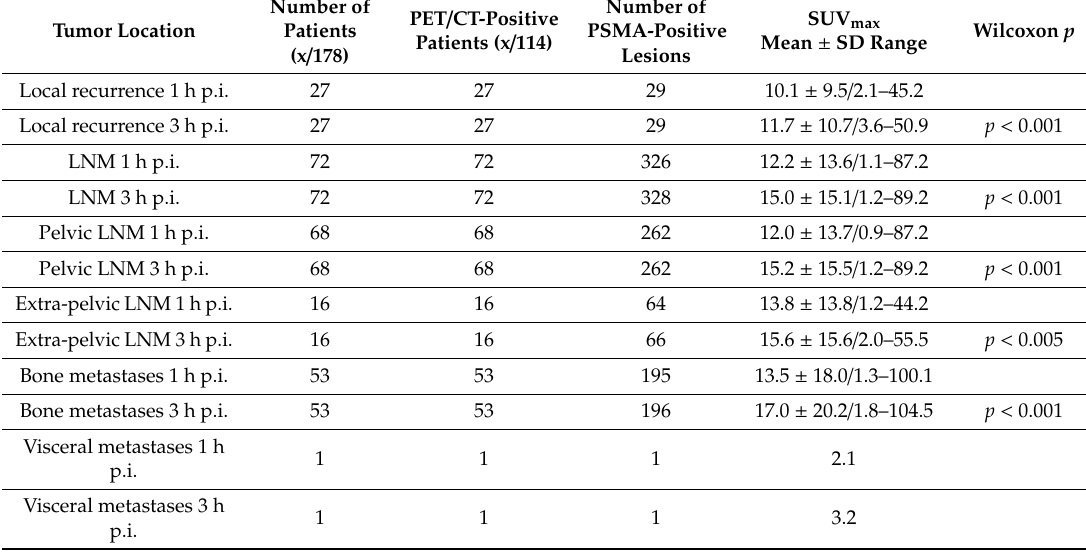
Figure 2. Comparison of baseline and delayed [ 68 Ga]Ga-PSMA-11 positron-emission tomography / computed tomography (PET / CT) regarding tracer uptake of prostate-specific membrane antigen (PSMA)-positive lesions (P-P). Table 3. Comparison of baseline and delayed PET / CT P-P related to tracer uptake of PSMA-positive lesions. Number of Number of PET / CT-Positive SUV max Tumor Location Patients PSMA-Positive Patients (x / 114) Mean SD (x / 178) Lesions ±